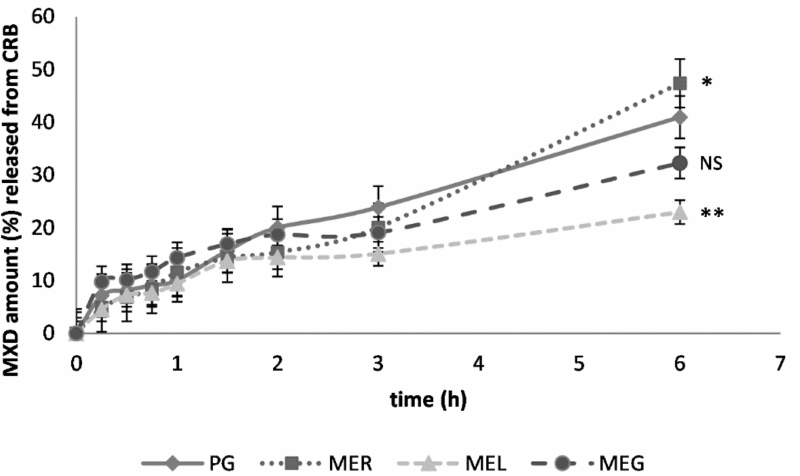
Figure 1. In vitro diffusion of MXD from carbomer gel (CRB) through semi-permeable membrane; previous solubilization in propylene glycol (PG), reference ME R , lecithin-containing ME L or gelatin- containing ME G . The cumulative MXD amount (%), a mean ± standard error of the mean (SEM), n = 4. Significantly different data against reference (PG) are at p < 0.05 (*), p < 0.01 (**), non-significantly different data (NS) are at p > 0.05.